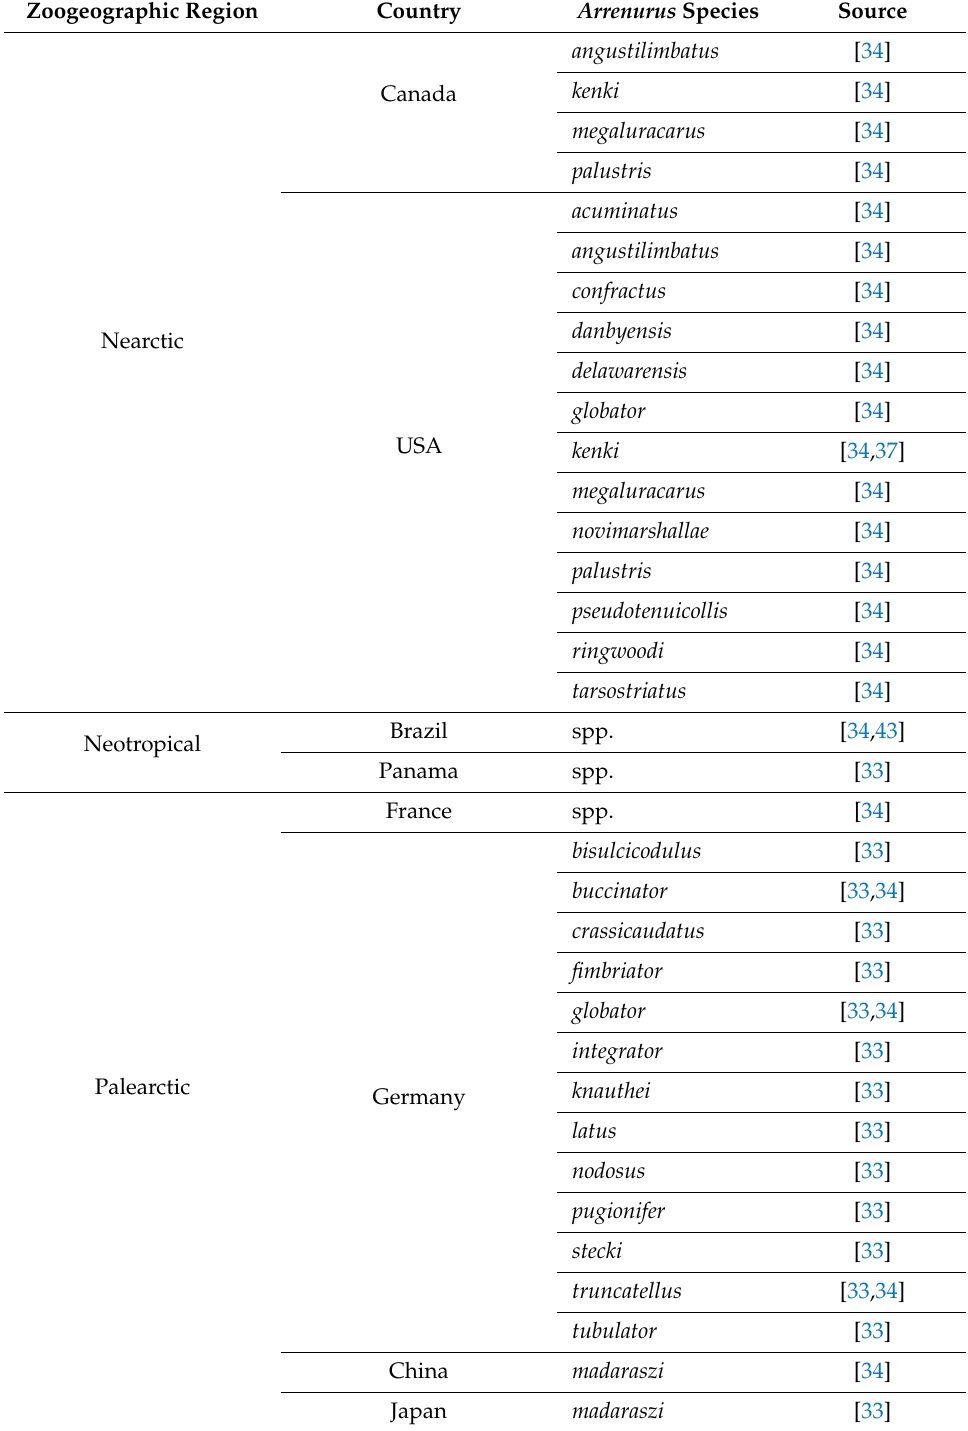
Table A3. Arrenurus species